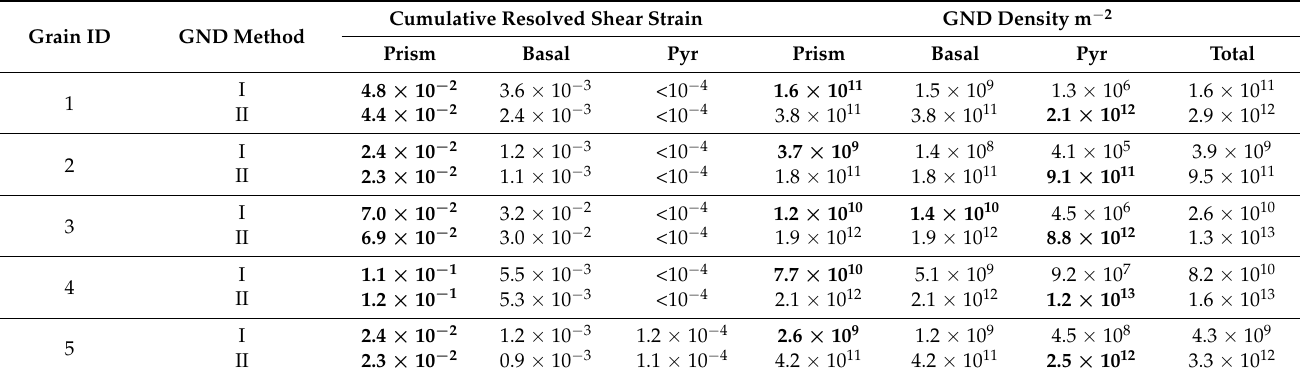
Table 2. Average resolved shear strains and GND densities from the CPFE models. Results are for grains G1 to G5 of the polycrystalline model at 1.2% applied strain. The predominant slip system is shown in bold. Grain ID GND